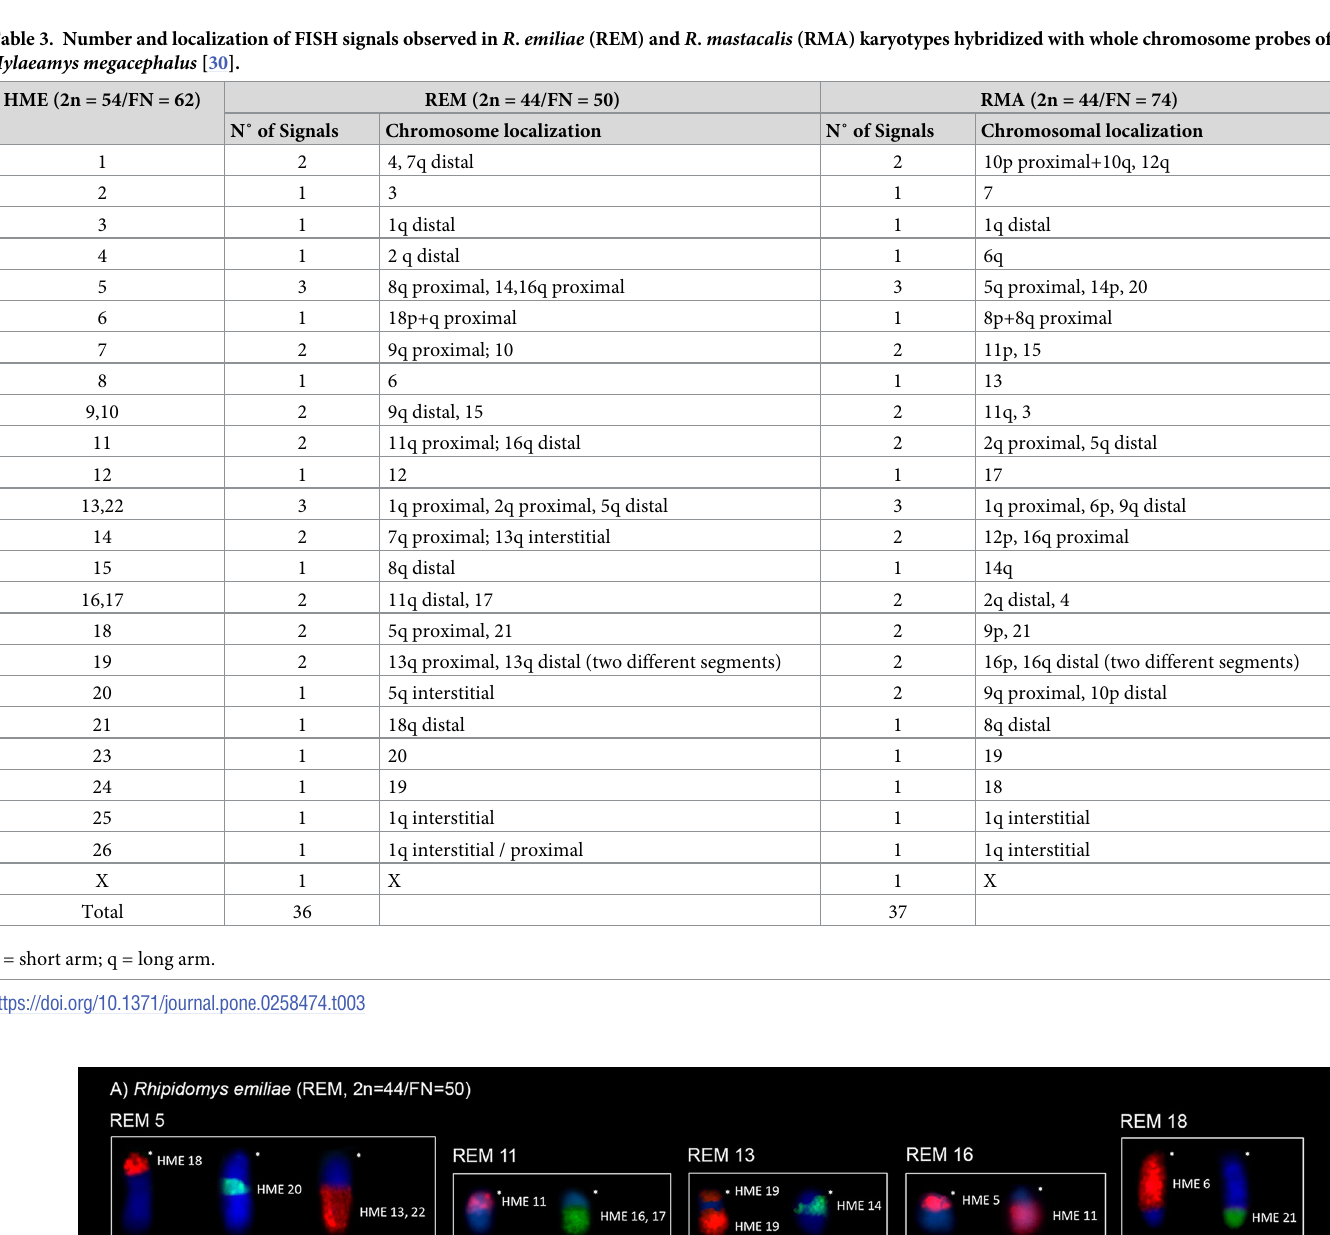
Table 3. Number and localization of FISH signals observed in R . emiliae (REM) and R . mastacalis (RMA) karyotypes hybridized with whole chromosome probes of Hylaeamys megacephalus [30].